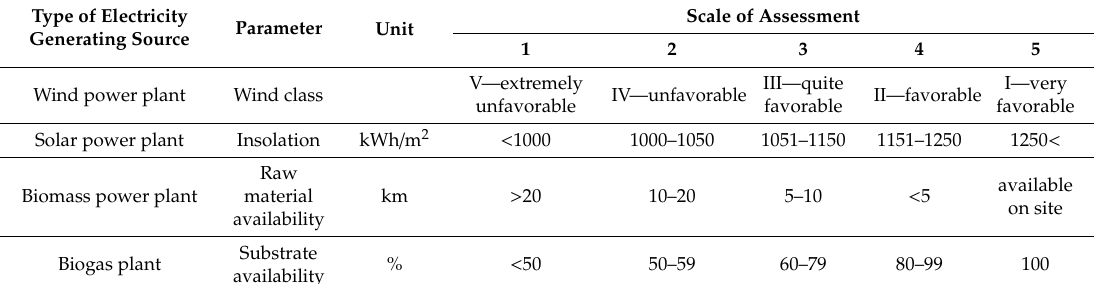
Table 2. Scale for the detailed criterion X 1,1 —the availability of primary raw materials.